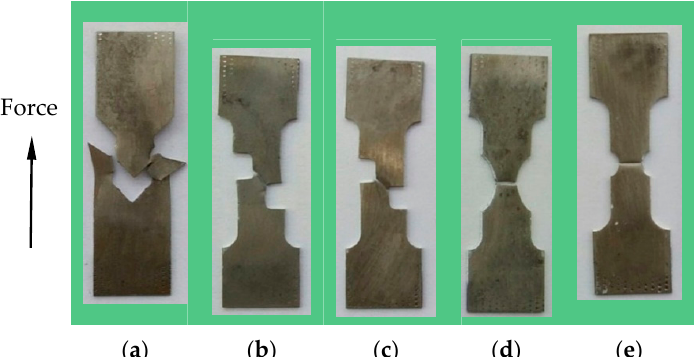
Figure 3. Macroscopic fracture morphology of five specimens. ( a ) S-0; ( b ) S-30; ( c ) S-45; ( d ) NT-R9; ( e ) NT-R3.